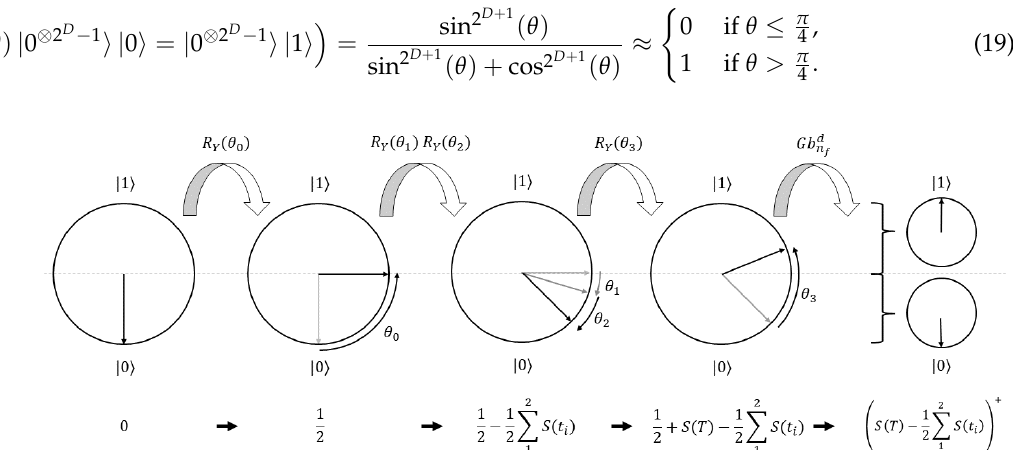
Figure 3. Representation of the quantum algorithm implementing the positive part of the value at maturity for n = 2. As the R Y -gate only rotates about the Y -axis, we can illustrate the employed rotations by showing the relevant 2-dimensional Bloch sphere of the used qubit. The used rotations are shown above, and the corresponding values are shown below. In the last step, the employed gearbox circuit sets a qubit in state | 1 (cid:105) for angles above π /4 and in state | 0 (cid:105) for angles below π /4, ultimately implementing the needed function q ( x k ) as shown in Equation